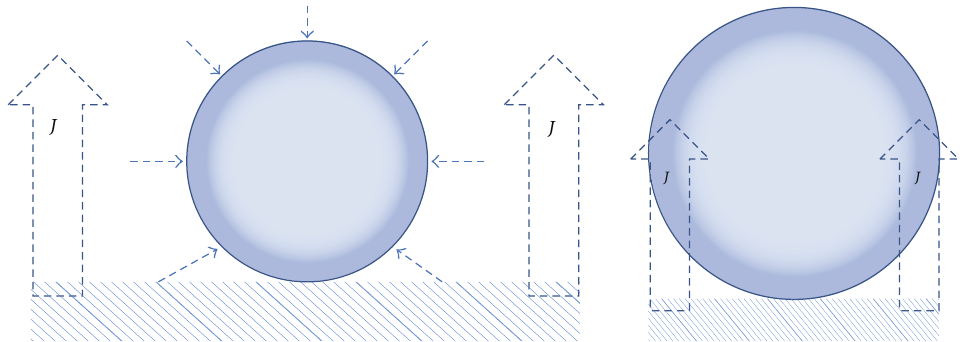
Figure 6: Bubble growth